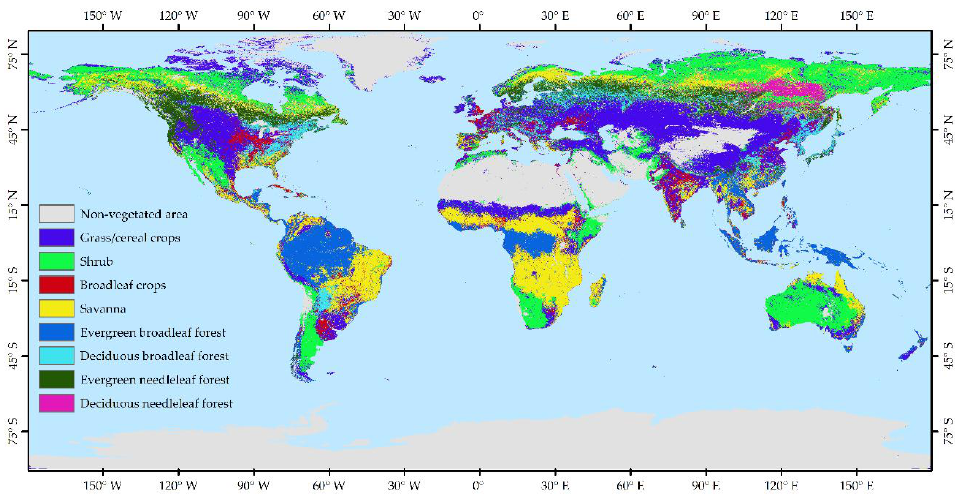
Figure 1. Global distribution of biome types in 2010 based on the moderate resolution imaging spectroradiometer (MODIS) Leaf Area Index (LAI)/Fraction of Absorbed Photosynthetically Active Radiation (FPAR) (Type 3) classification system.